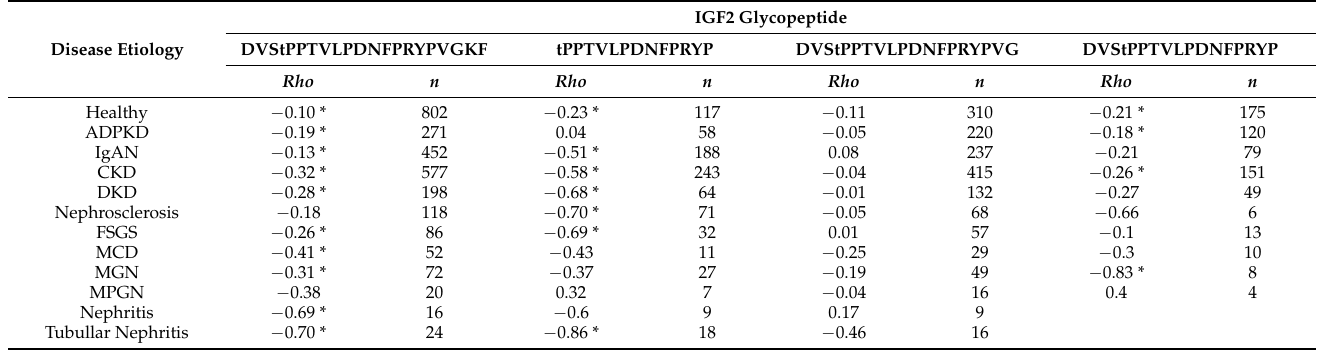
Table 2. Results of Spearman’s rank correlation test for the abundance of urinary IGF2 glycopeptides with eGFR (mL/min/1.73 m 2 ) in different kidney disease etiologies. The significant correlations ( p < 0.05) are marked with an asterisk.